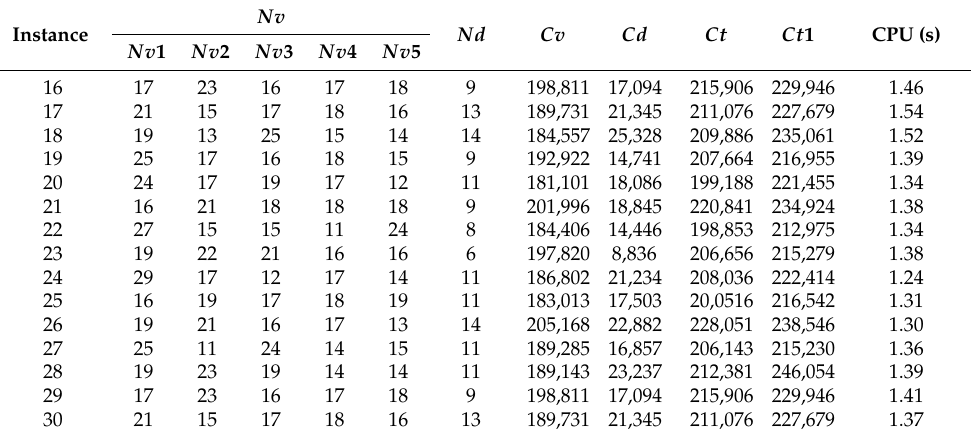
Table 2. Heuristic solutions for the 100-node